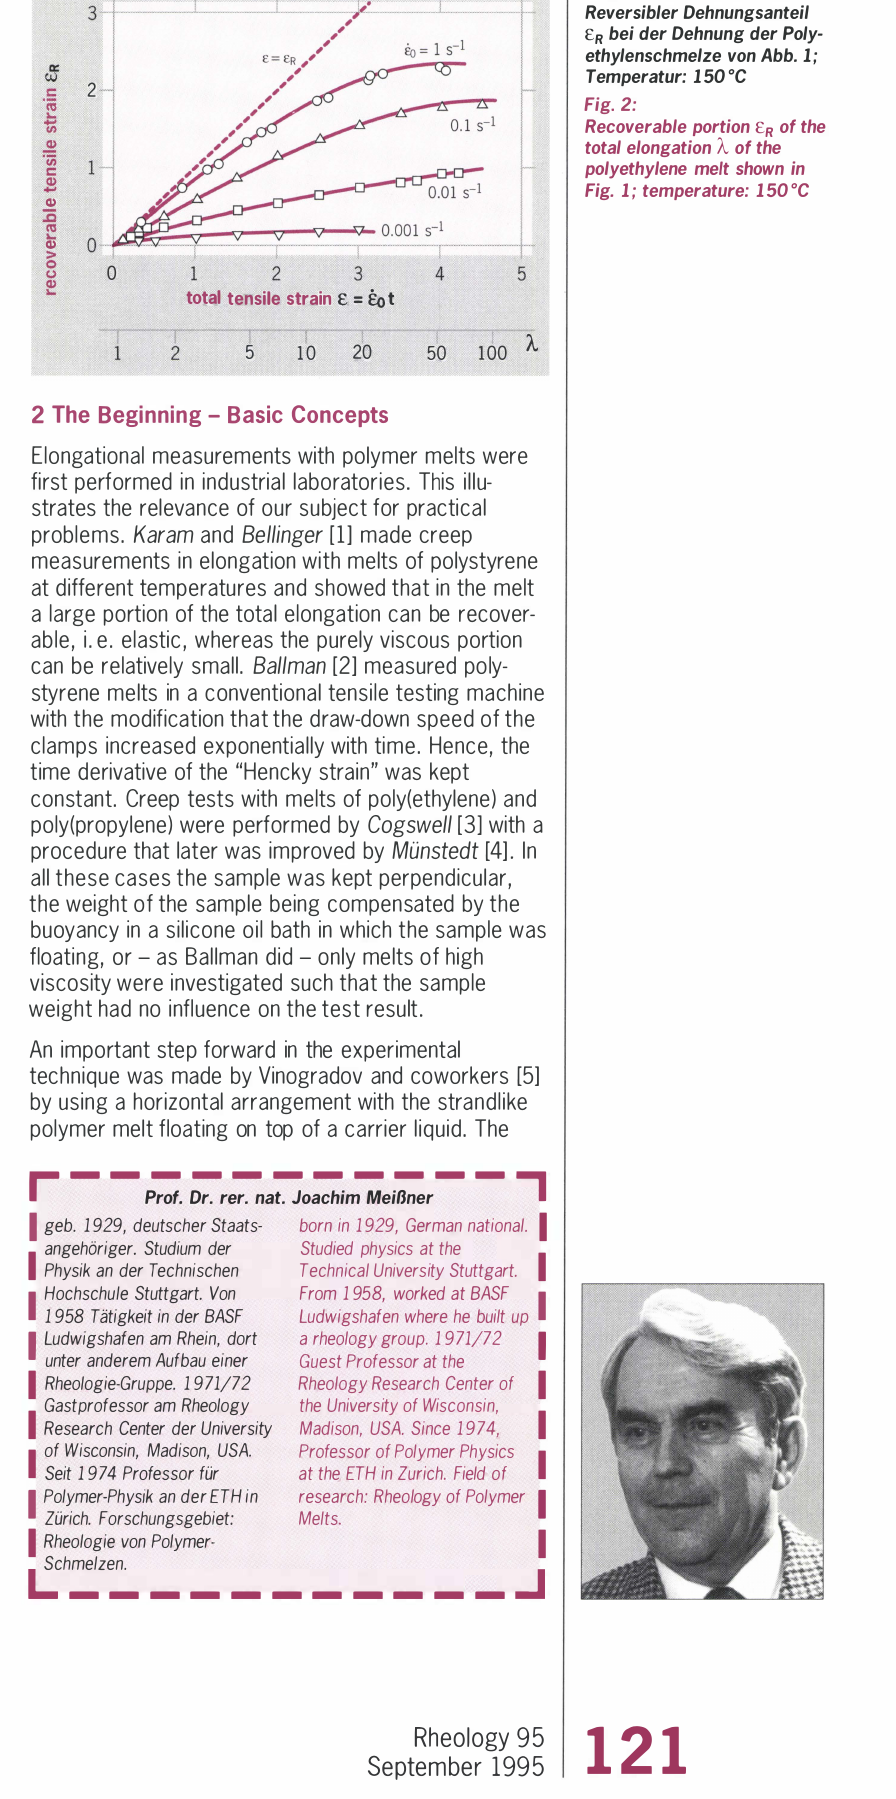
Fig. 1: Transient elongational and shear viscosities j1(1) and ll(t), respectively, of a melt of branched polyethylene, see [10] and [11]